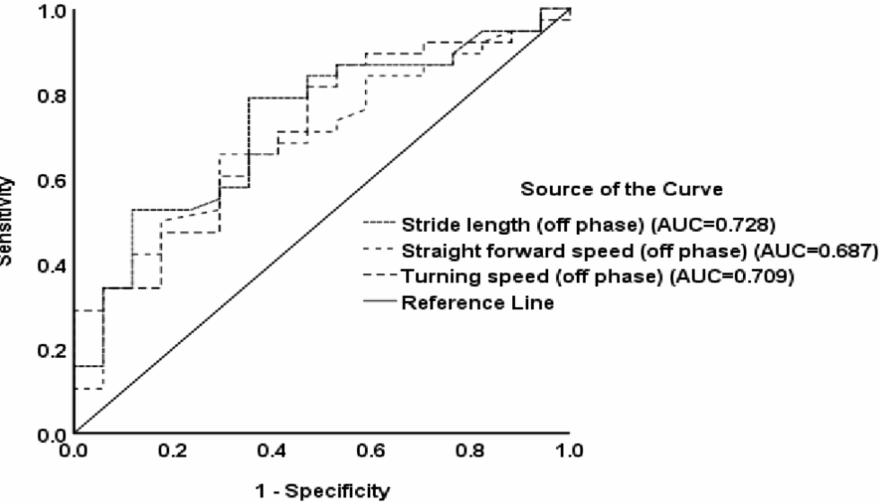
Figure 1. Receiver operator characteristic curves for predicting the presence of falling. The diagnostic accuracy of the spatiotemporal parameters is shown based on the receiver operating characteristic curve analysis ( p < 0.05).